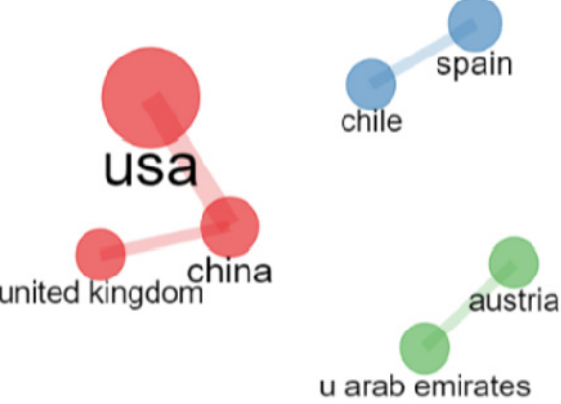
Figure 10. Inter-country collaboration networks ( ≥ 1 collaboration).